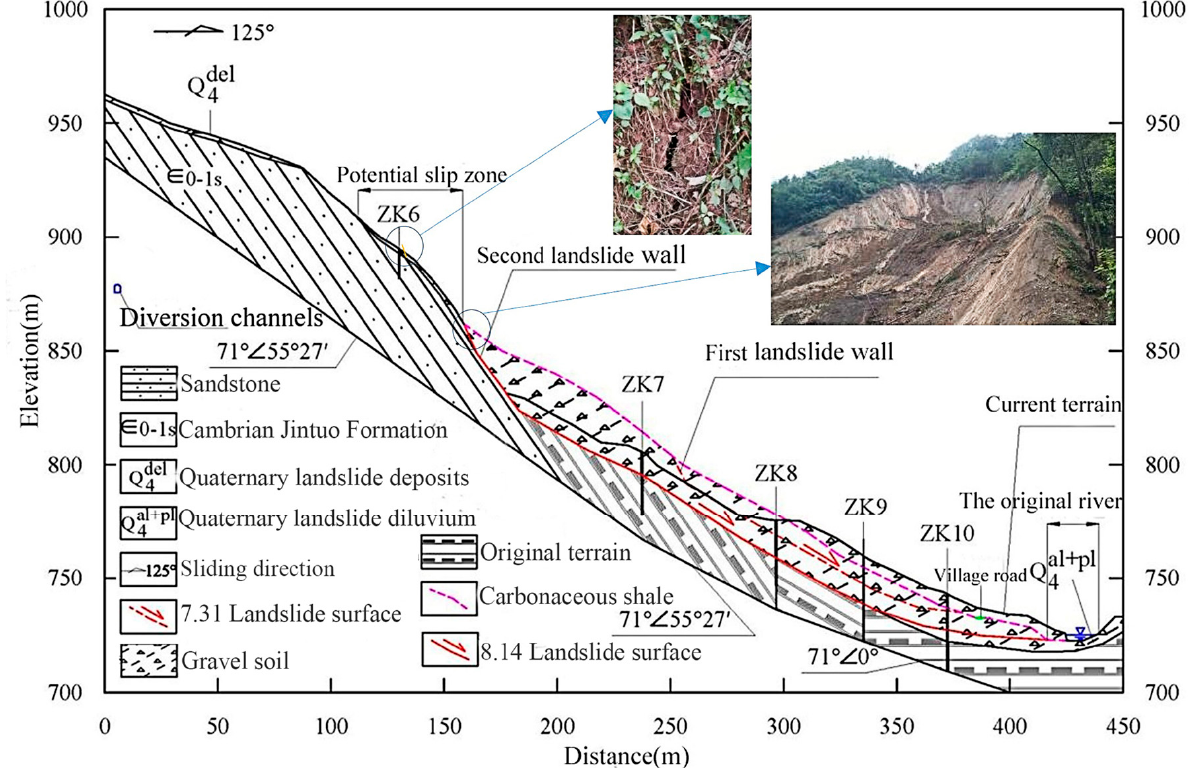
Figure 5. The 2-2 profile and trailing edge tension crack of the landslide